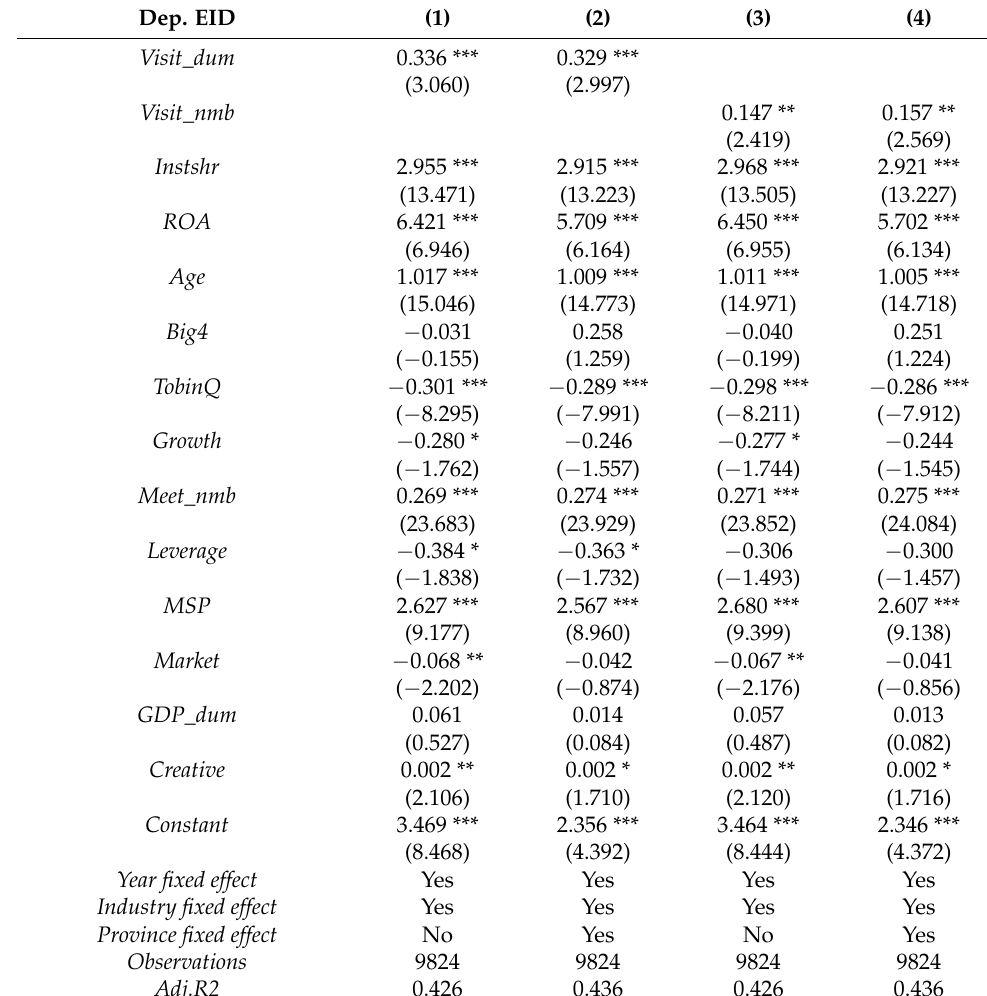
Table 3. Regression results of analyst site visits on